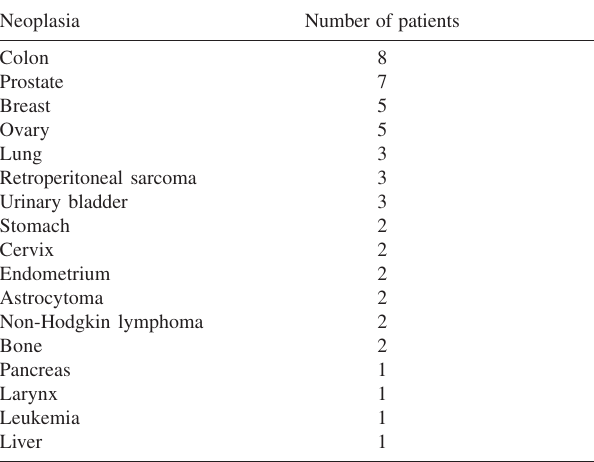
Table 1 - Location of the cancer in patients submitted to vena cava filter implantation